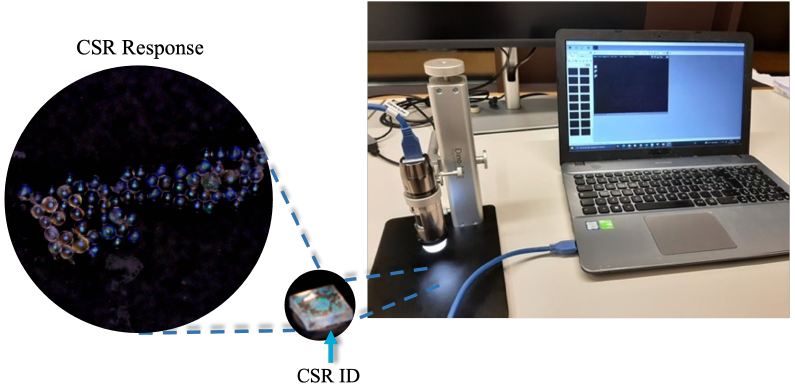
Figure 3. CSR ID : physical object composed by CSRs hardened into a matrix—that can be a polymeric or a glass. CSR response : image acquired from the physical object by using a Dino-Lite